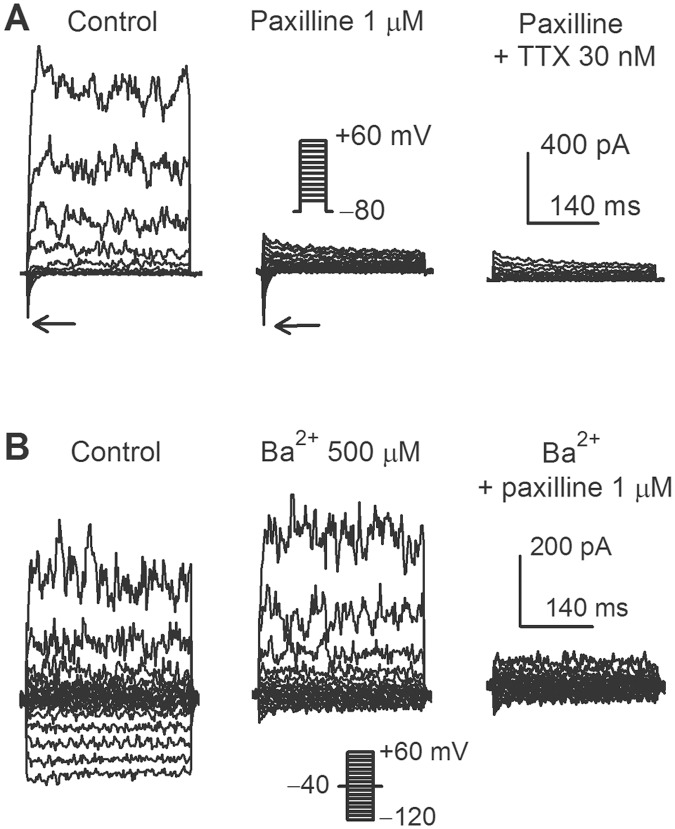
Inhibition of membrane current by ion channel blockers in human cardiac c-kit+ progenitor cells.
(A): BKCa and INa.TTX were co-expressed in a human cardiac c-kit+ progenitor cell, and inhibited respectively by 1 μM paxilline and 30 nM TTX. (B): IKir and BKCa were co-expressed in a typical human cardiac c-kit+ progenitor cell, and inhibited respectively by 500 μM Ba2+ and 1 μM paxilline.